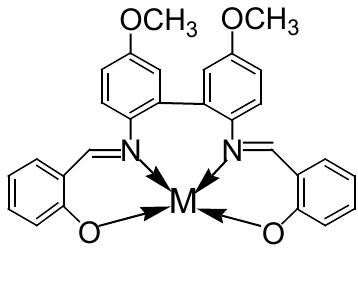
Figure 2. The proposed chemical structure for the transition metal